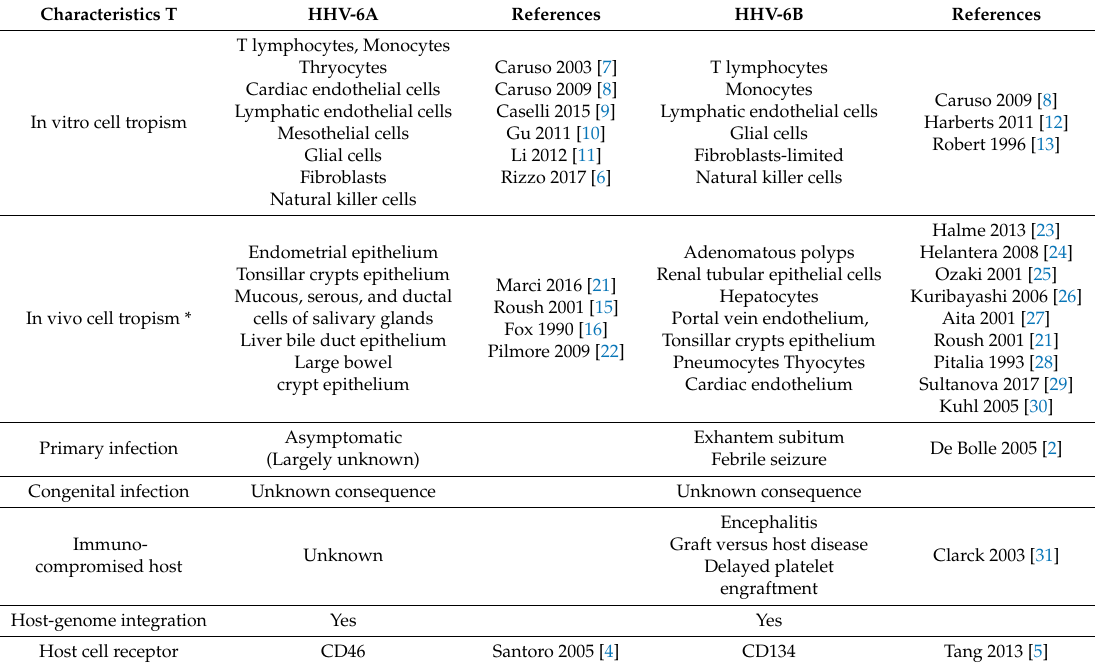
Table 1. HHV-6A and HHV-6B host-interaction